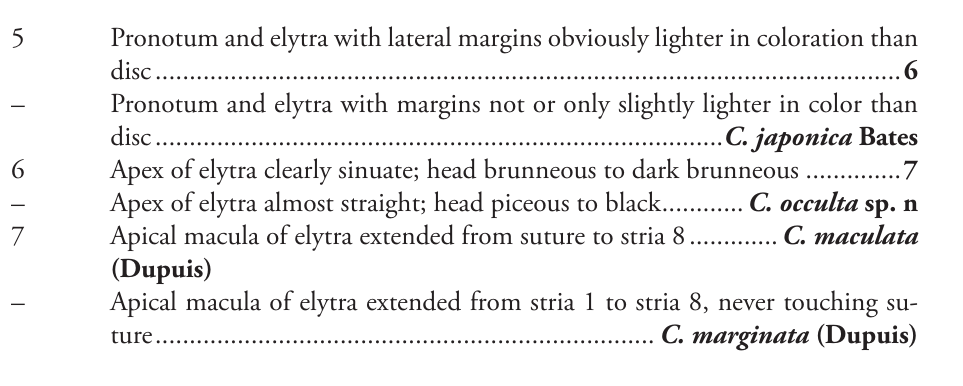
Color . Fig. 36A, B. Dorsum of head brunneo-piceous to piceous, clypeus and labrum brunneo-testaceous to rufo-brunneous, antennae and palpi rufo-brunneous; disc of pronotum brunneo-piceous to piceous, lateral margins testaceous to brunne- ous, always lighter then disc, some transparent at margins; disc of elytra black, with four testaceous macula, two anterior and two posterior, variable, anterior macula from interval 3 to 7 (some 3 to 6), closest to base of elytra in interval 5, closest to apex of elytra in interval 4 and 5, posterior macula from stria 1 to interval 8, closest to